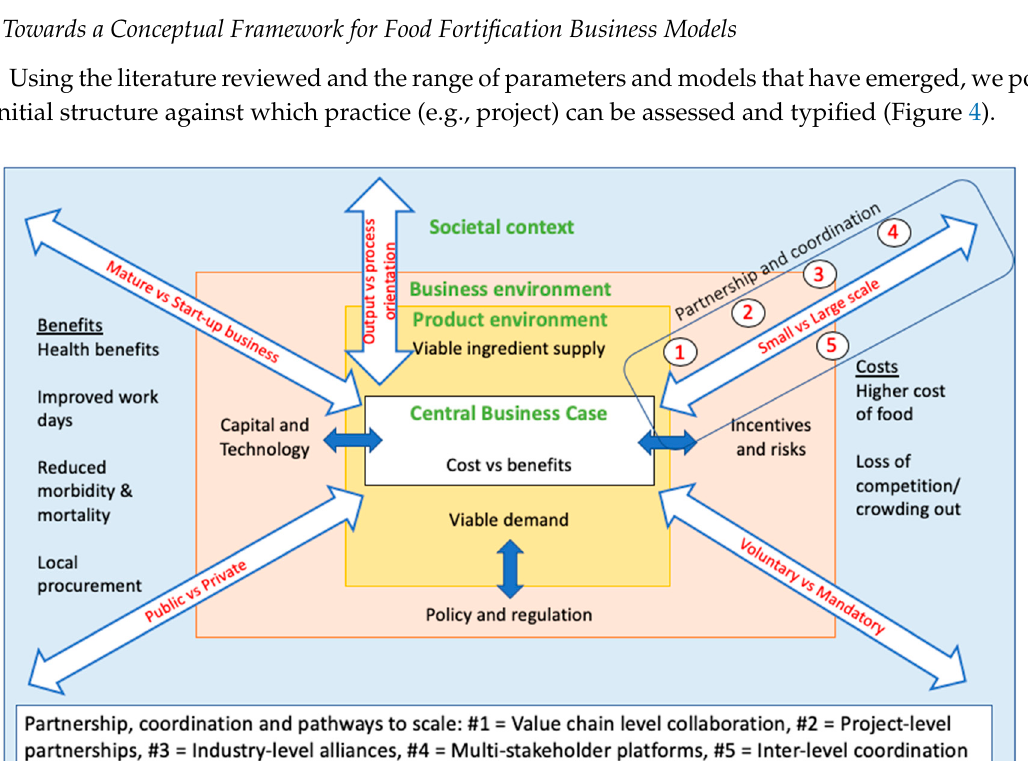
Figure 4. Initial structure for understanding different business cases.